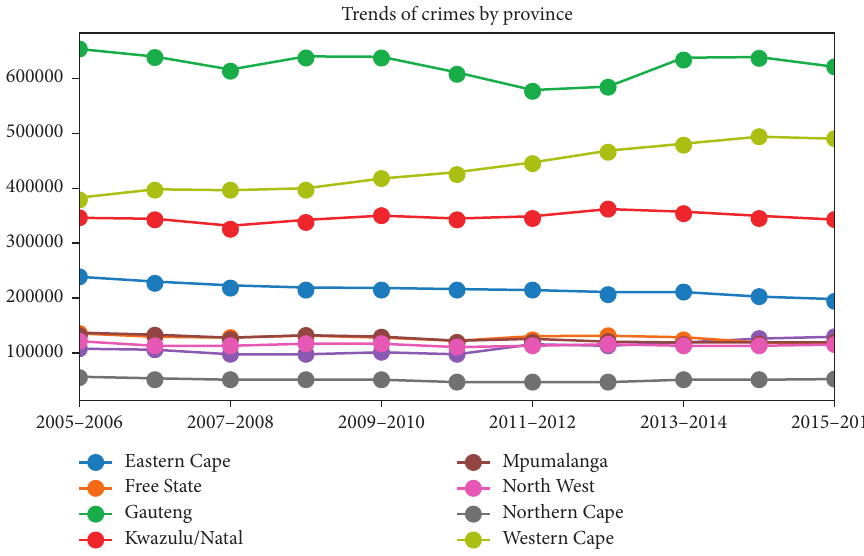
Figure 5: All province total crime